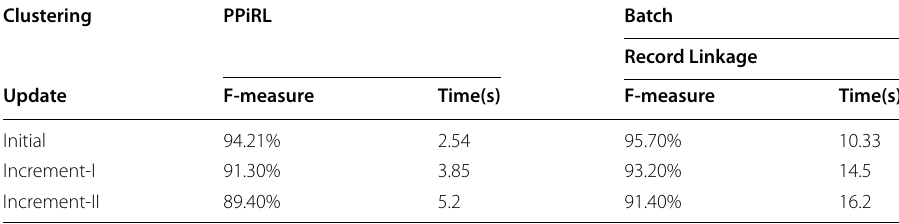
Table 8 Comparison between PPiRL and batch record linkage Clustering